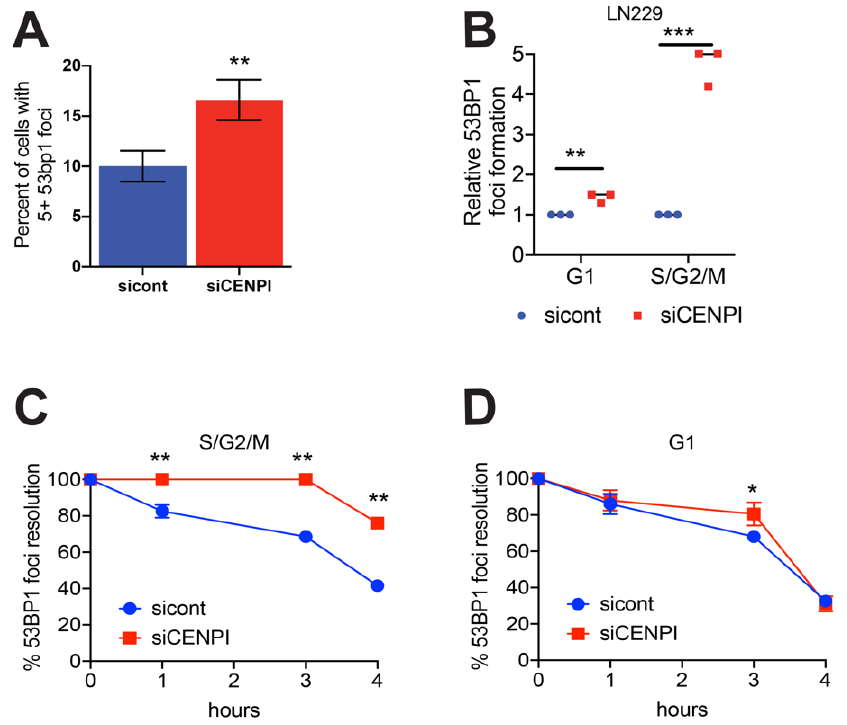
Figure 3. Loss of CENP-I results in increased 53BP1 foci. ( A ) 53BP1 foci were examined in LN229 cells with and without CENP-I. ( B ) 53BP1 foci were measured in G1 and S/G2/M LN229 cells. ( C , D ) 53BP1 foci were measured in G1 and S/G2/M at 1, 3 and 4 h after exposure to ionizing radiation (1 Gy). Statistical analysis was performed using Student’s t -test. * = p ≤ 0.05, ** = p ≤ 0.01, *** = p ≤ 0.001.